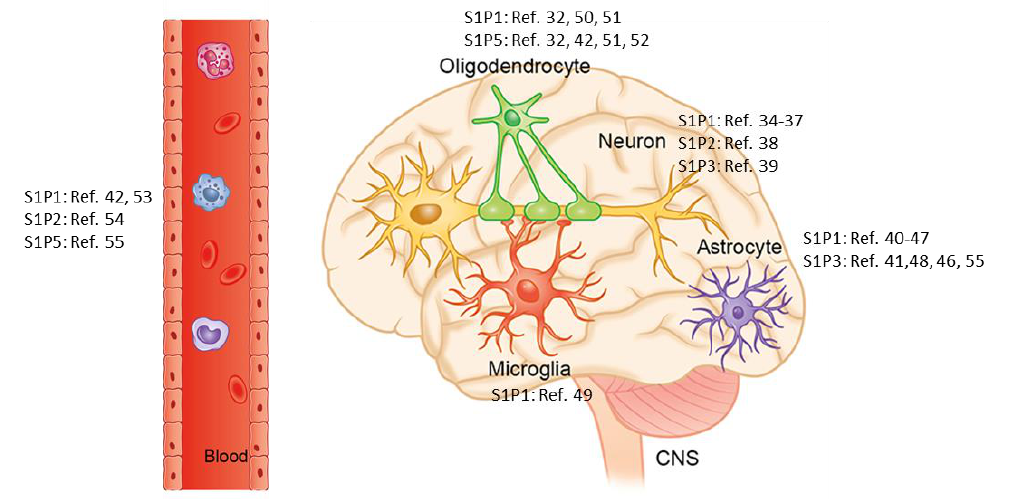
Figure 1. Sphingosine 1-phosphate receptor expression in the central nervous system: Schematic illustrating the expression of Sphingosine 1-phosphate (S1P) receptor subtypes 1–5 (referred to as S1P1–5) in the cells of the central nervous system. Note that S1P receptors are expressed by endothelial cells as well. References: [34]; [35]; [36]; [37]; [38]; [39]; [40]; [41]; [42]; [43]; [31]; [44]; [45]; [46]; [47];